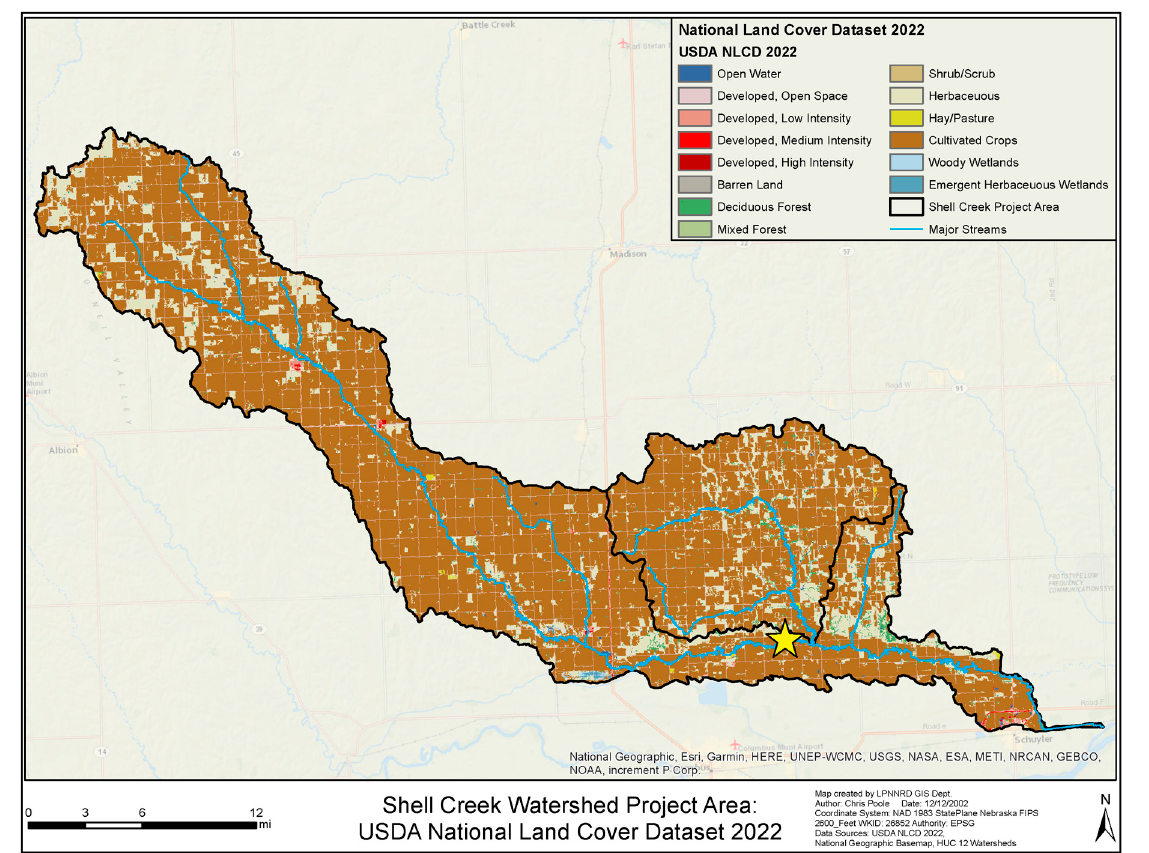
Figure 1. Shell Creek Watershed with USDA 2022 land cover data. The location of the streamflow gauge used for this study is indicated by a yellow star.